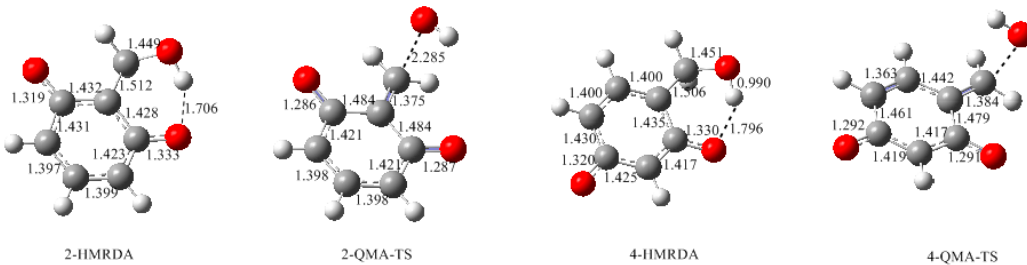
Figure 8. The calculated structures for the intermediates and transition states for the E1cb formation of quinonemethide anions.